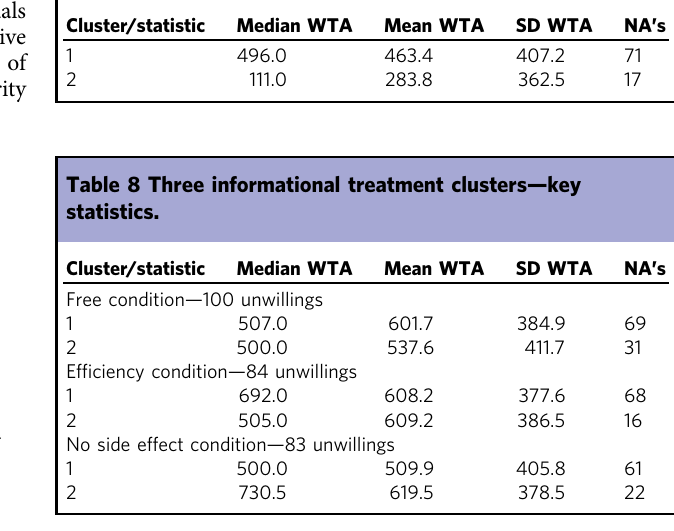
Table 7 Control condition clusters — key statistics.